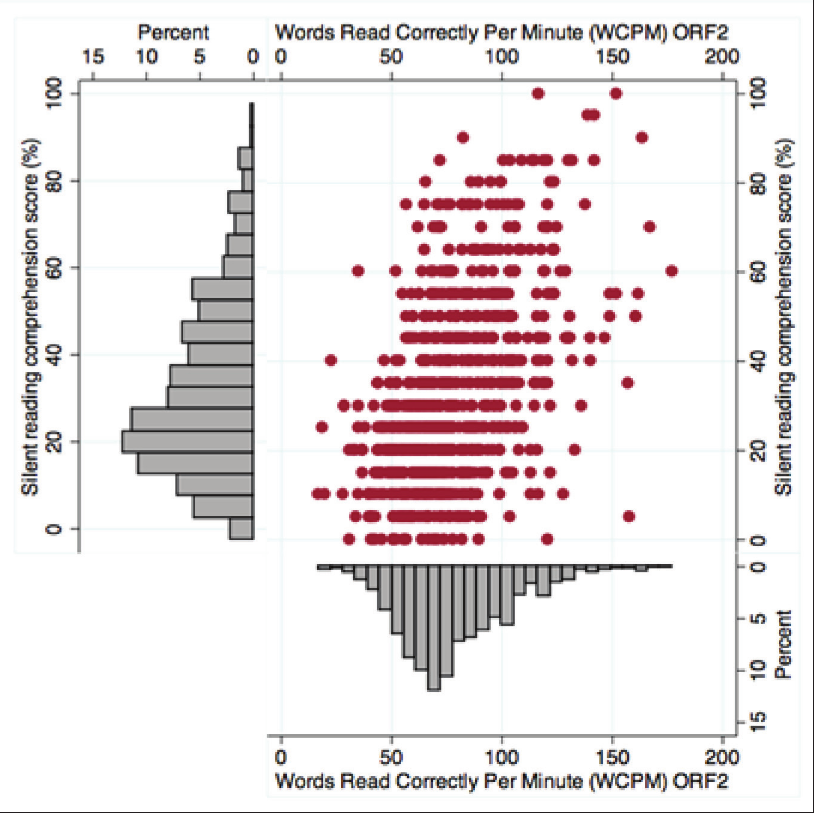
Figure 3: Distributions of silent reading comprehension (in percent) and ORF (in WCPM) for the ORF 2 sample (correlation: 0.50;